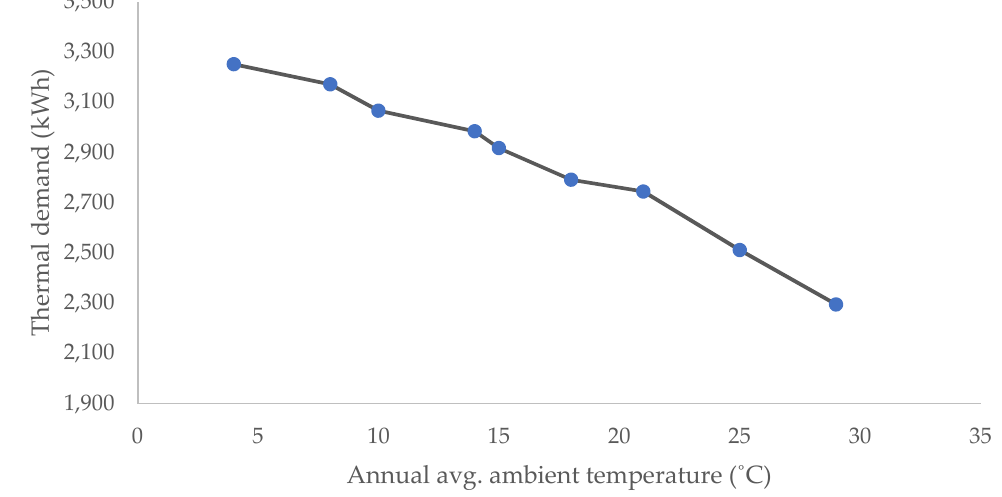
Figure 16. Total thermal demand of single-family house relation with the average ambient temperature.